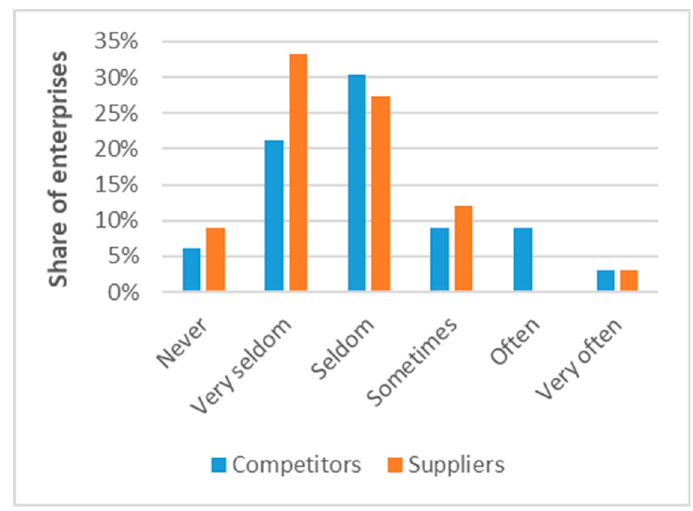
Figure 13. Barriers to company innovation.